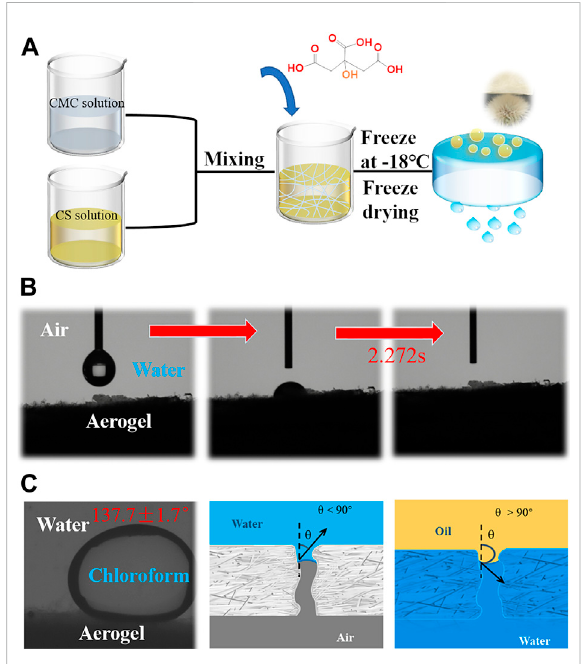
FIGURE 1 (A) The illustration for the manufacture procedure of CA/CS/ CMC composite aerogel, (B) water droplet on aerogel surface in air, (C) chloroform droplet on aerogel surface underwater, (D) and (E) wetting behavior and process of water in the pores of